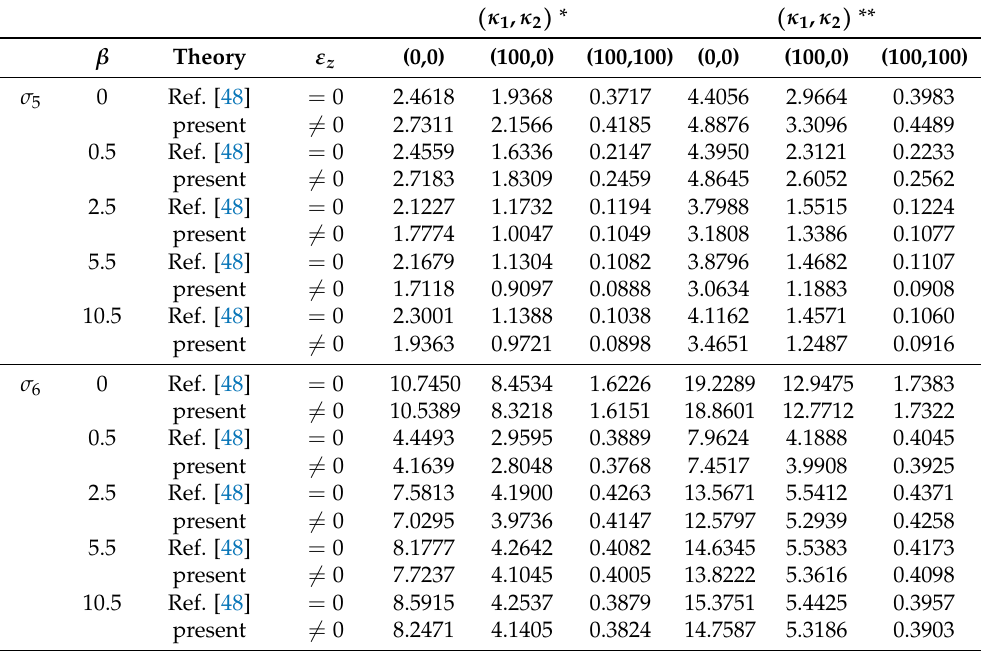
Table 6. Effects of the nonlocal coefficient and FG parameter on transverse shear stress σ 5 and in-plane tangential stress σ 6 in the FG square nanoplate for different values of the foundation parameters ( a / h =